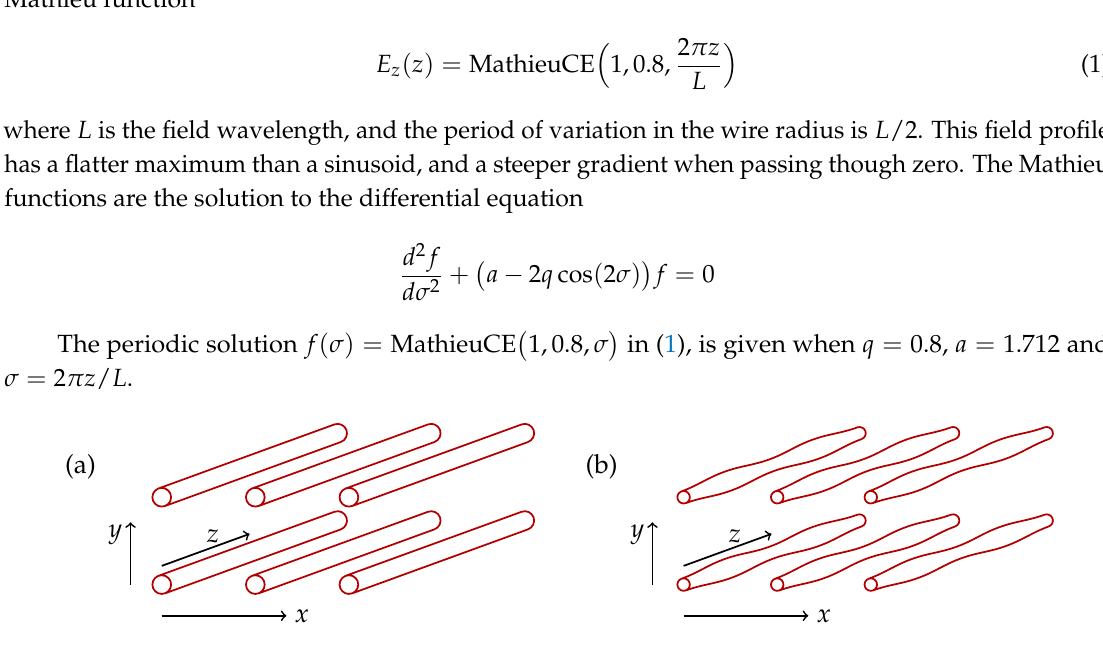
Figure 1. A wire medium is formed from an array of parallel metal or dielectric wires. In this work we use results based on rectangular arrays of ( a ) wires with uniform radii to predict the parameters needed for customised ( b ) wires with varying radii that generate a desired subwavelength field profile shaping.